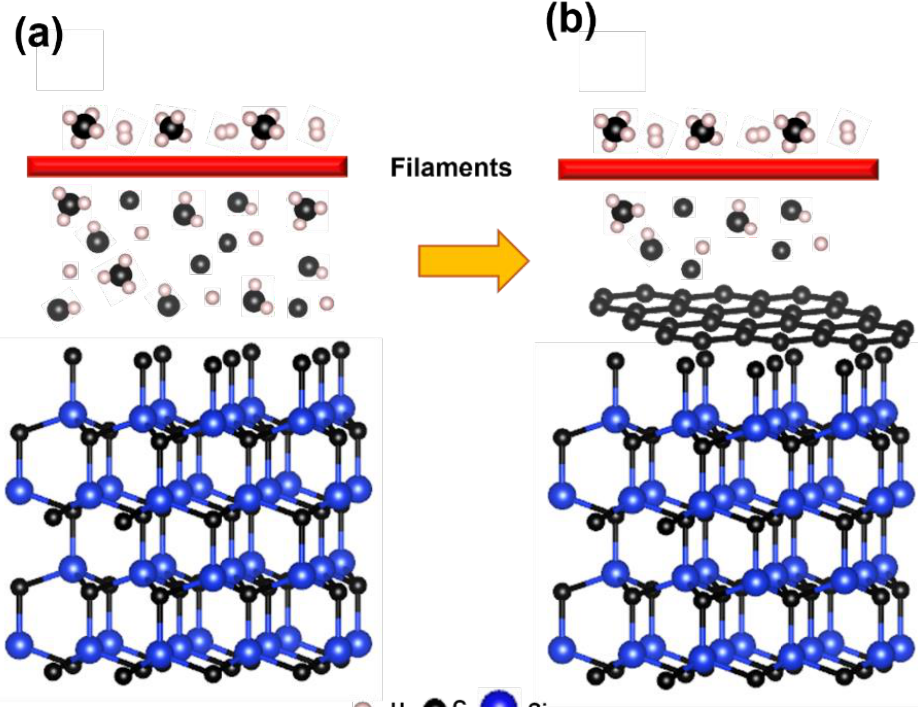
Figure 8. Graphene growth mechanism on SiC. ( a ) the dehydrogenation of methane by the hot filaments and ( b ) the reactive species deposit carbon atoms, stabilizing the SiC/C surface to form the graphene film.